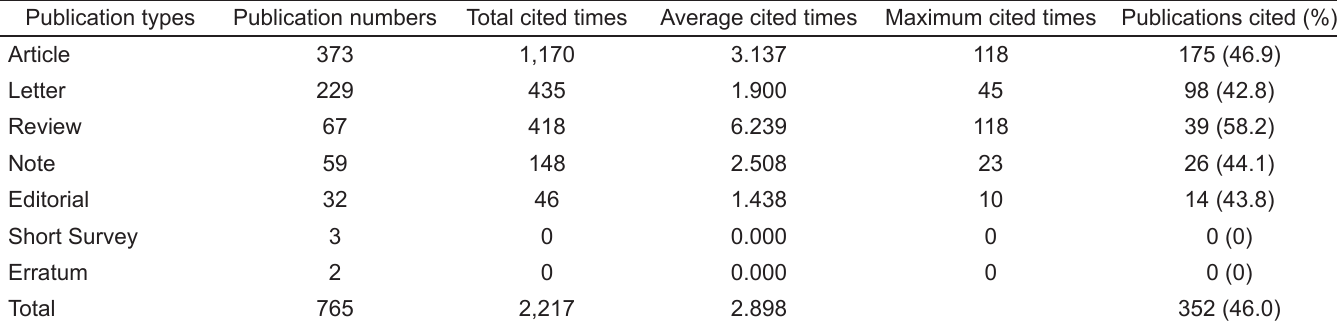
Table 3. Times-cited analysis of coronavirus disease 2019